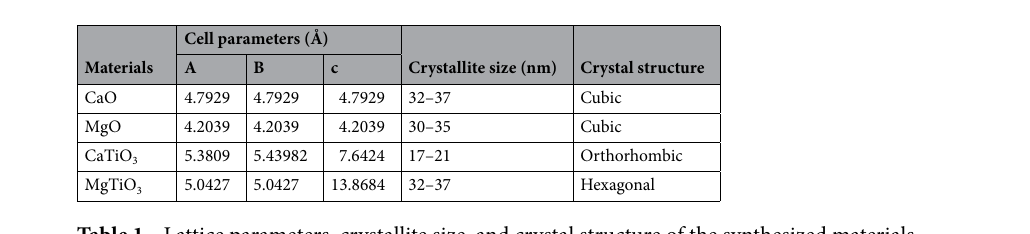
Table 1. Lattice parameters, crystallite size, and crystal structure of the synthesized materials.